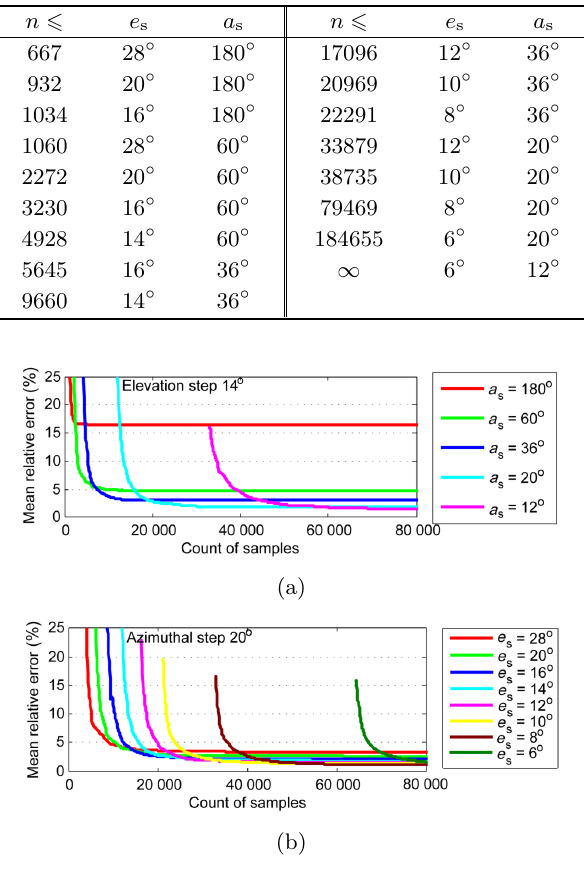
Table 1 Optimal values of the parameters a s , e s for various chosen numbers of samples